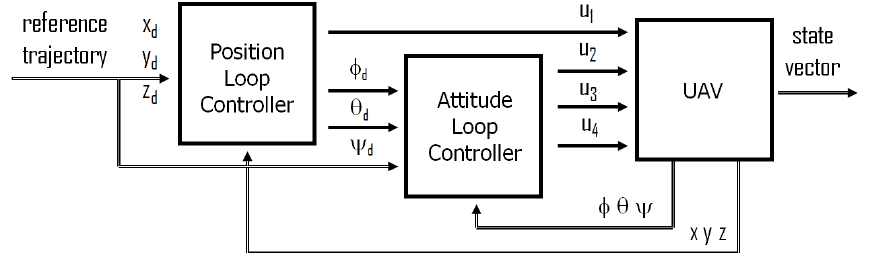
Figure 2. Block diagram for autonomous control of the UAV (thrust and torques u i for i = 1, . . . ,4 are defined in Equation (15).